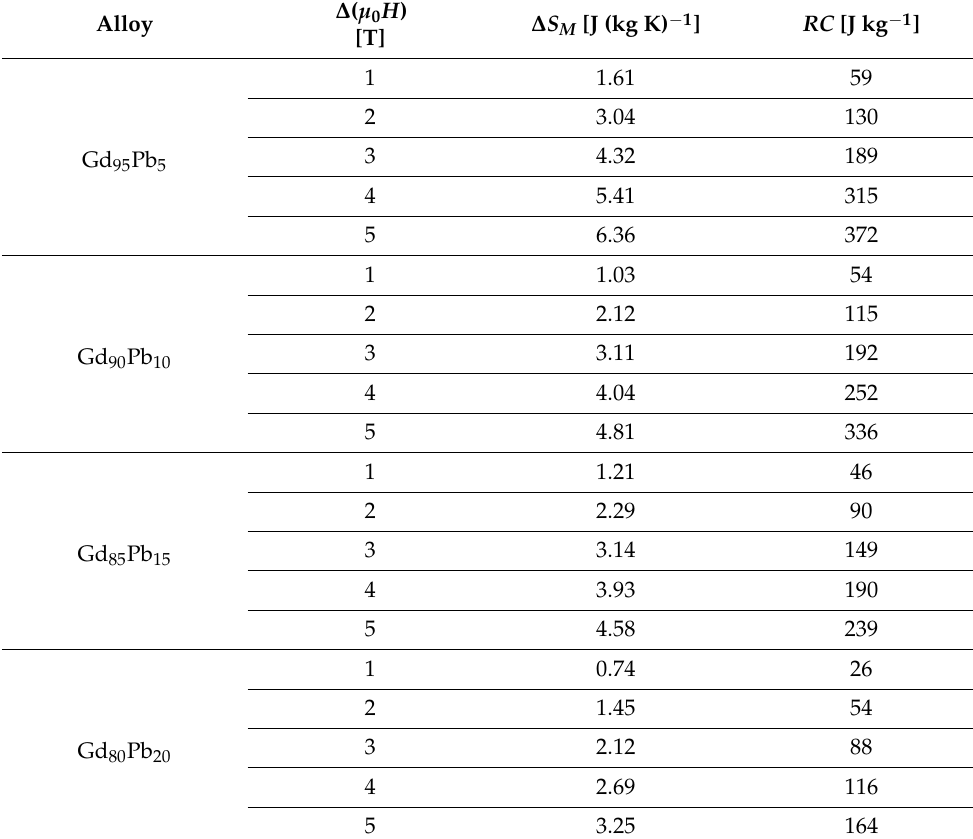
Table 4. Values of the ∆ S M and RC determined for studied